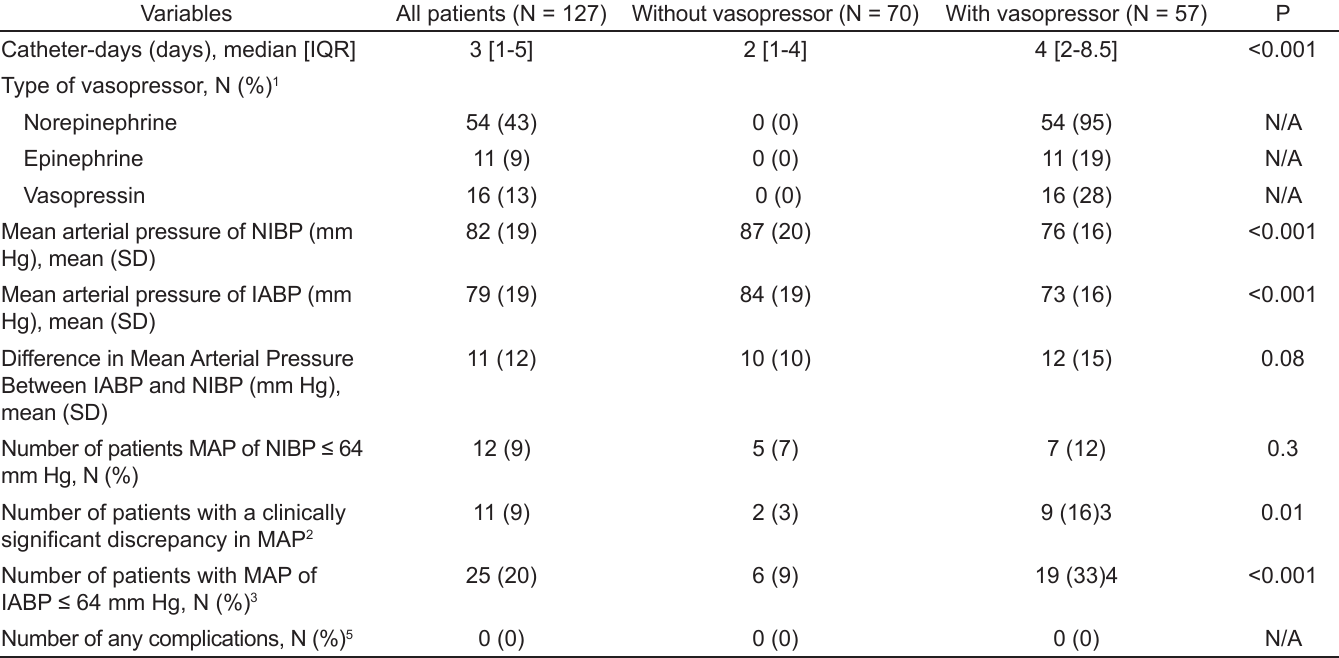
Table 2. Comparison between blood pressure from IABP and NIBP monitoring modalities for septic patients. Patients requiring vasopressors had a greater likelihood of clinically significant discrepancy between IABP and NIBP compared to patients without vasopressor